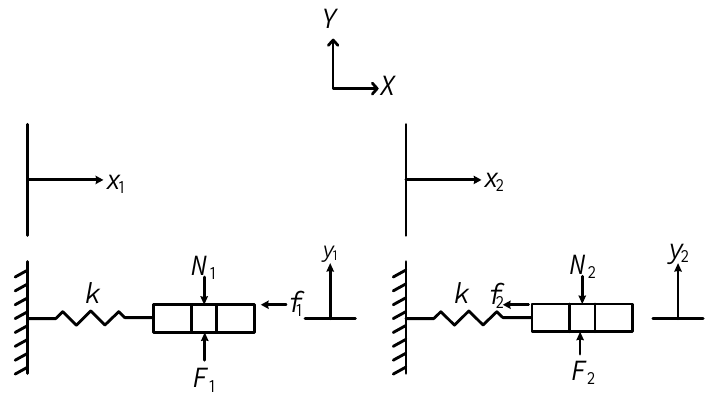
Figure 3. The mechanical model of the simplified blade-platform system.